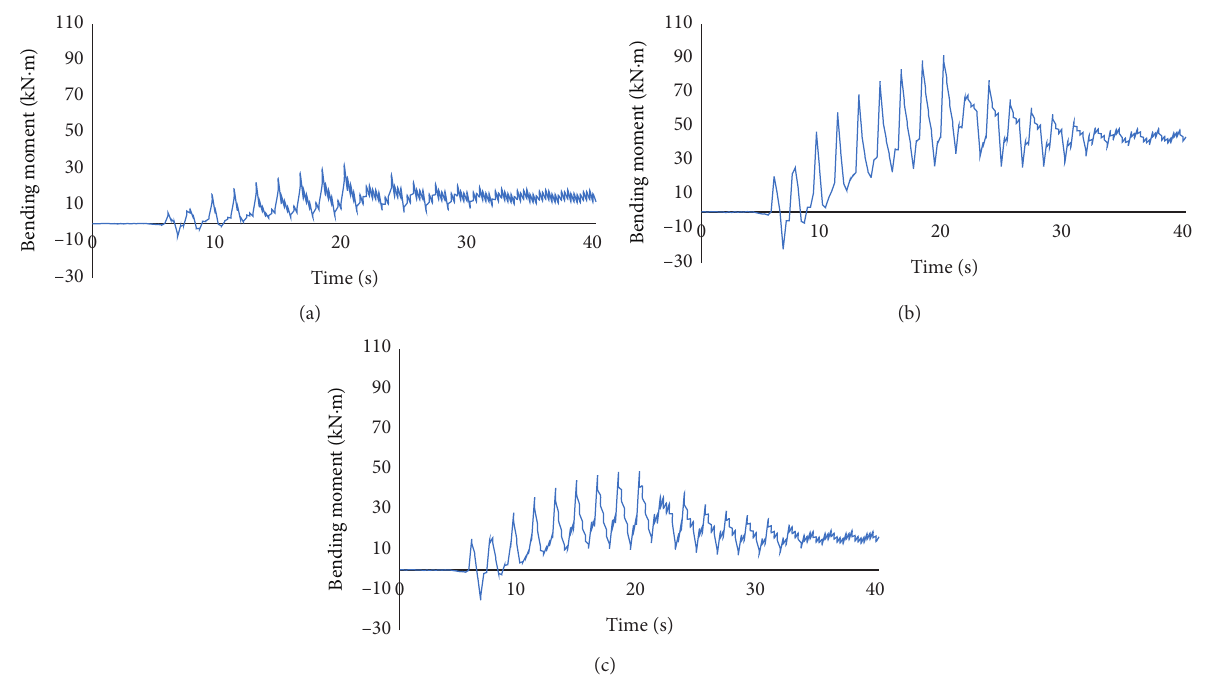
Figure 12: Bending moment of the single pile under the input motion-1 at different depths of pile: (a) D D 1 �